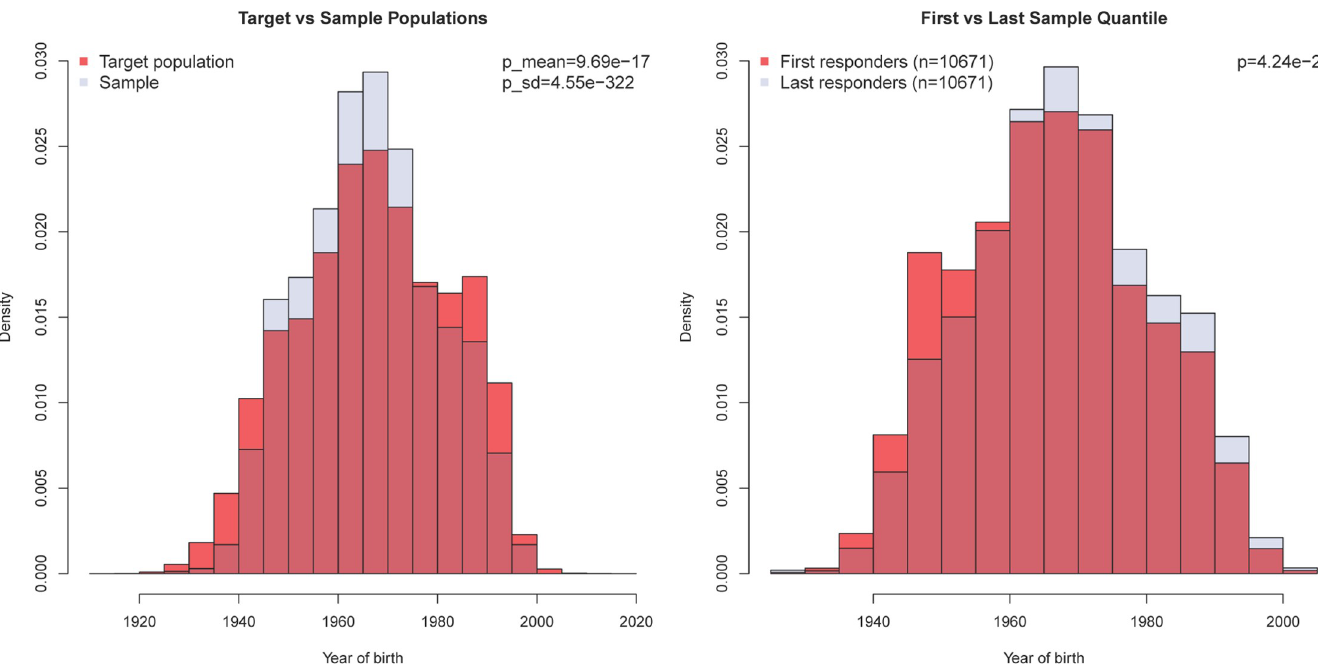
Fig 2. Age distribution in target and sample populations. Age distribution in target (dog owners registered in the Swedish Board of Agricultures register) and sample populations of dog owners (left) and first vs last quantiles of the sample (right). The sample population had a narrower age distribution than the target population and the last responders were systematically younger than the first responders.